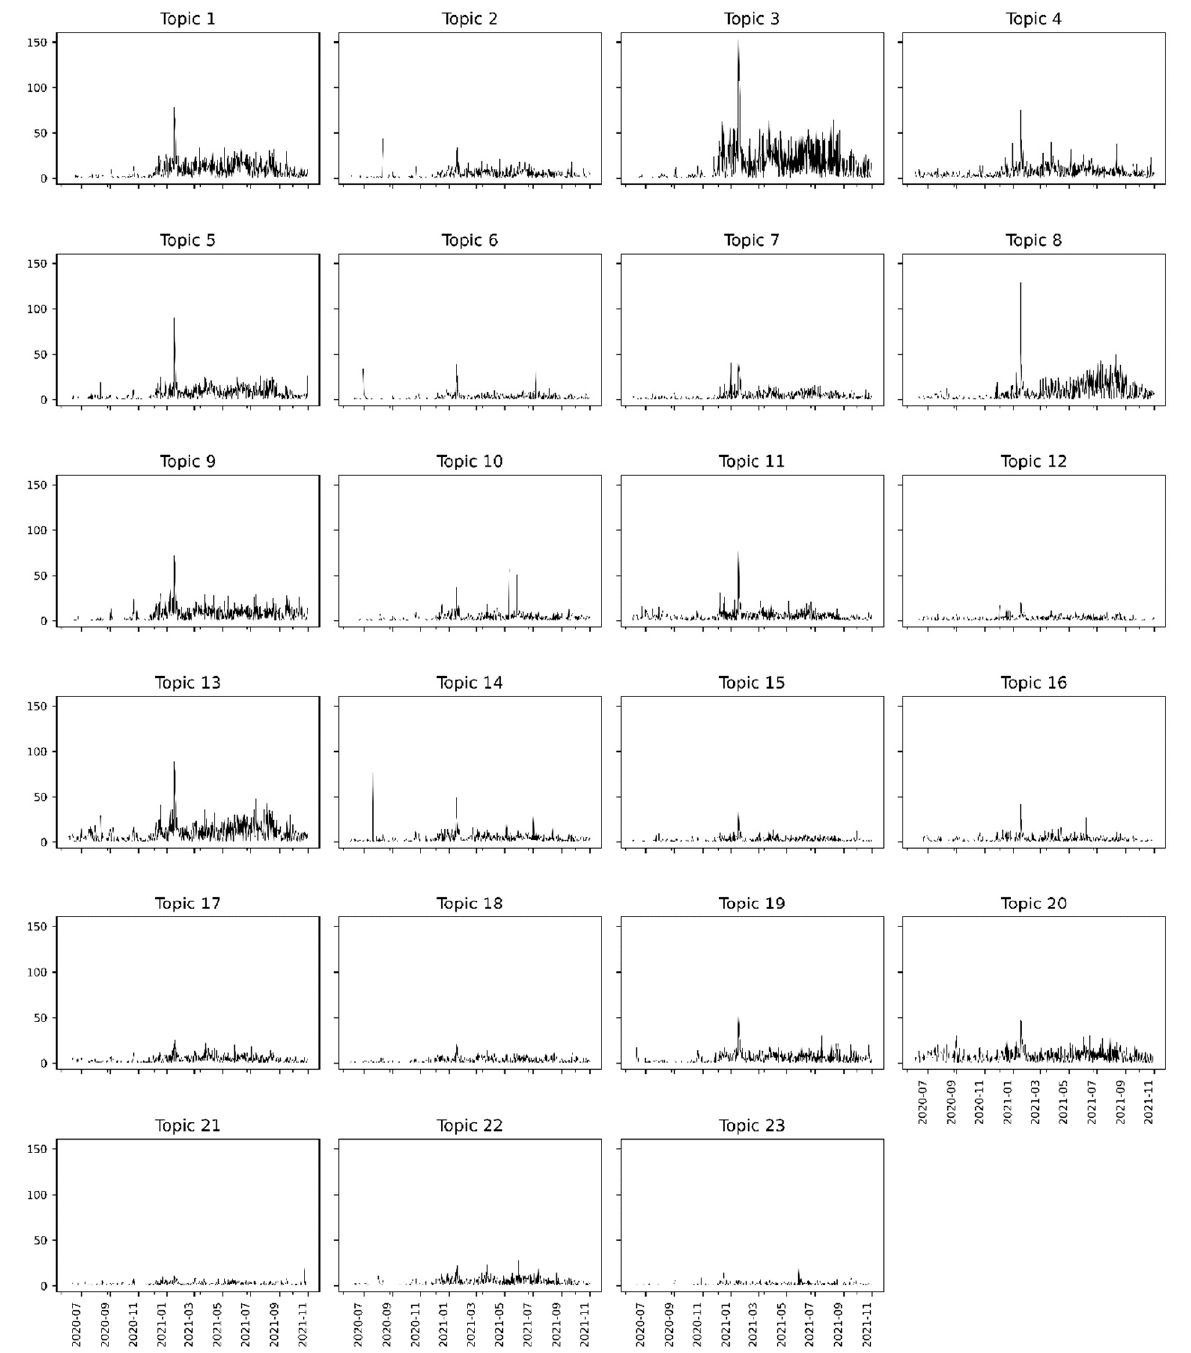
Figure 9. Timeline for each extracted topic, counting the number of tweets per day within the considered